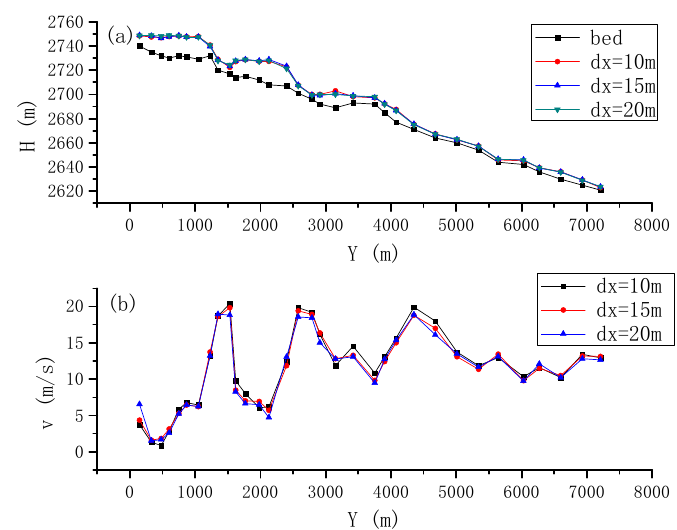
Figure 19. Spatial variations of ( a ) water surface; and ( b ) velocity profile along the central streamwise direction of dam break flow, for different particle spacing.